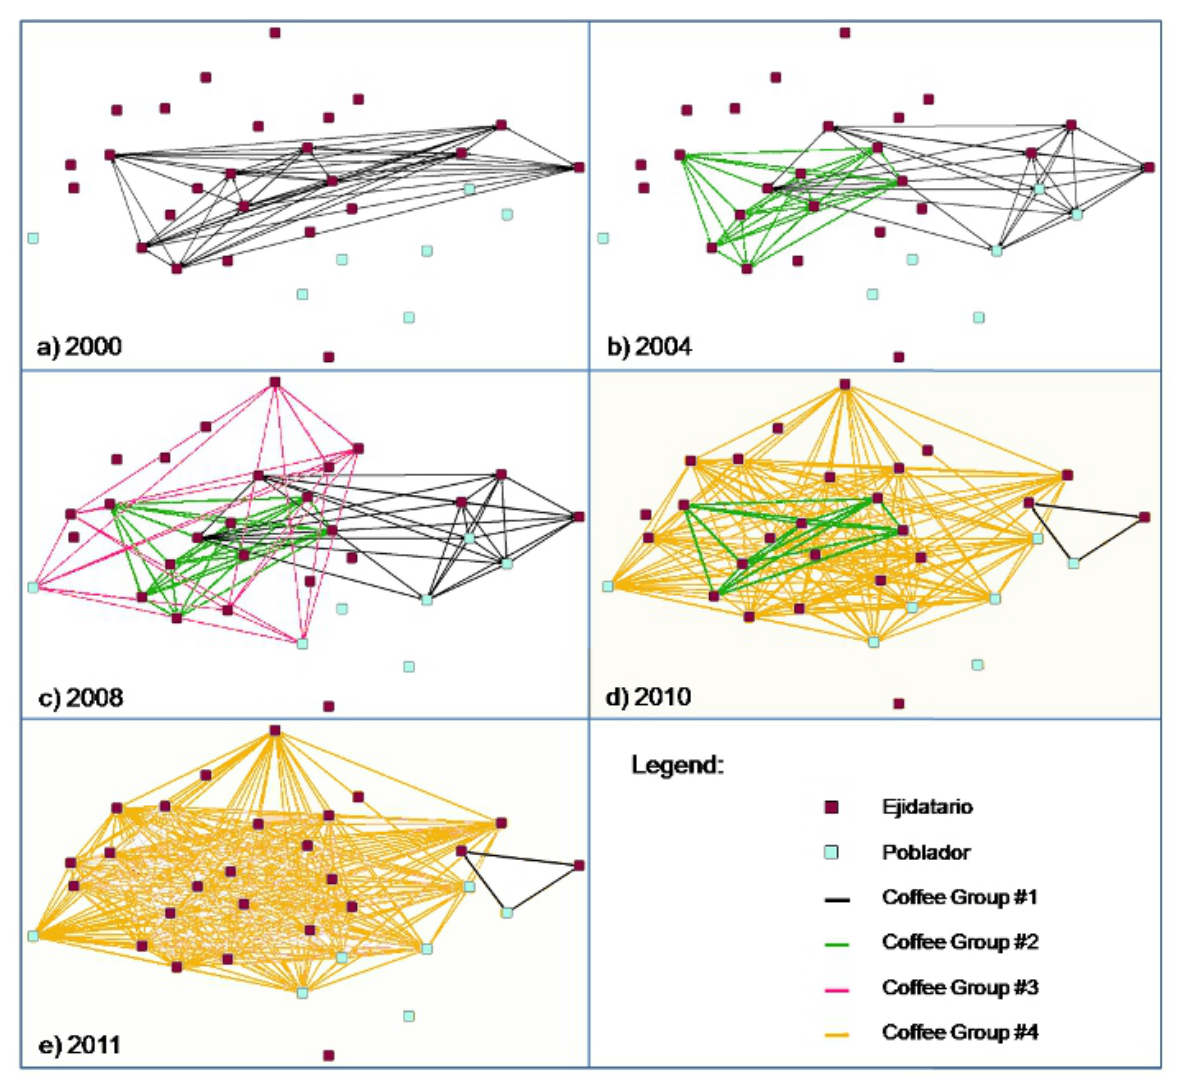
Fig. 4 . Evolution of coffee groups,